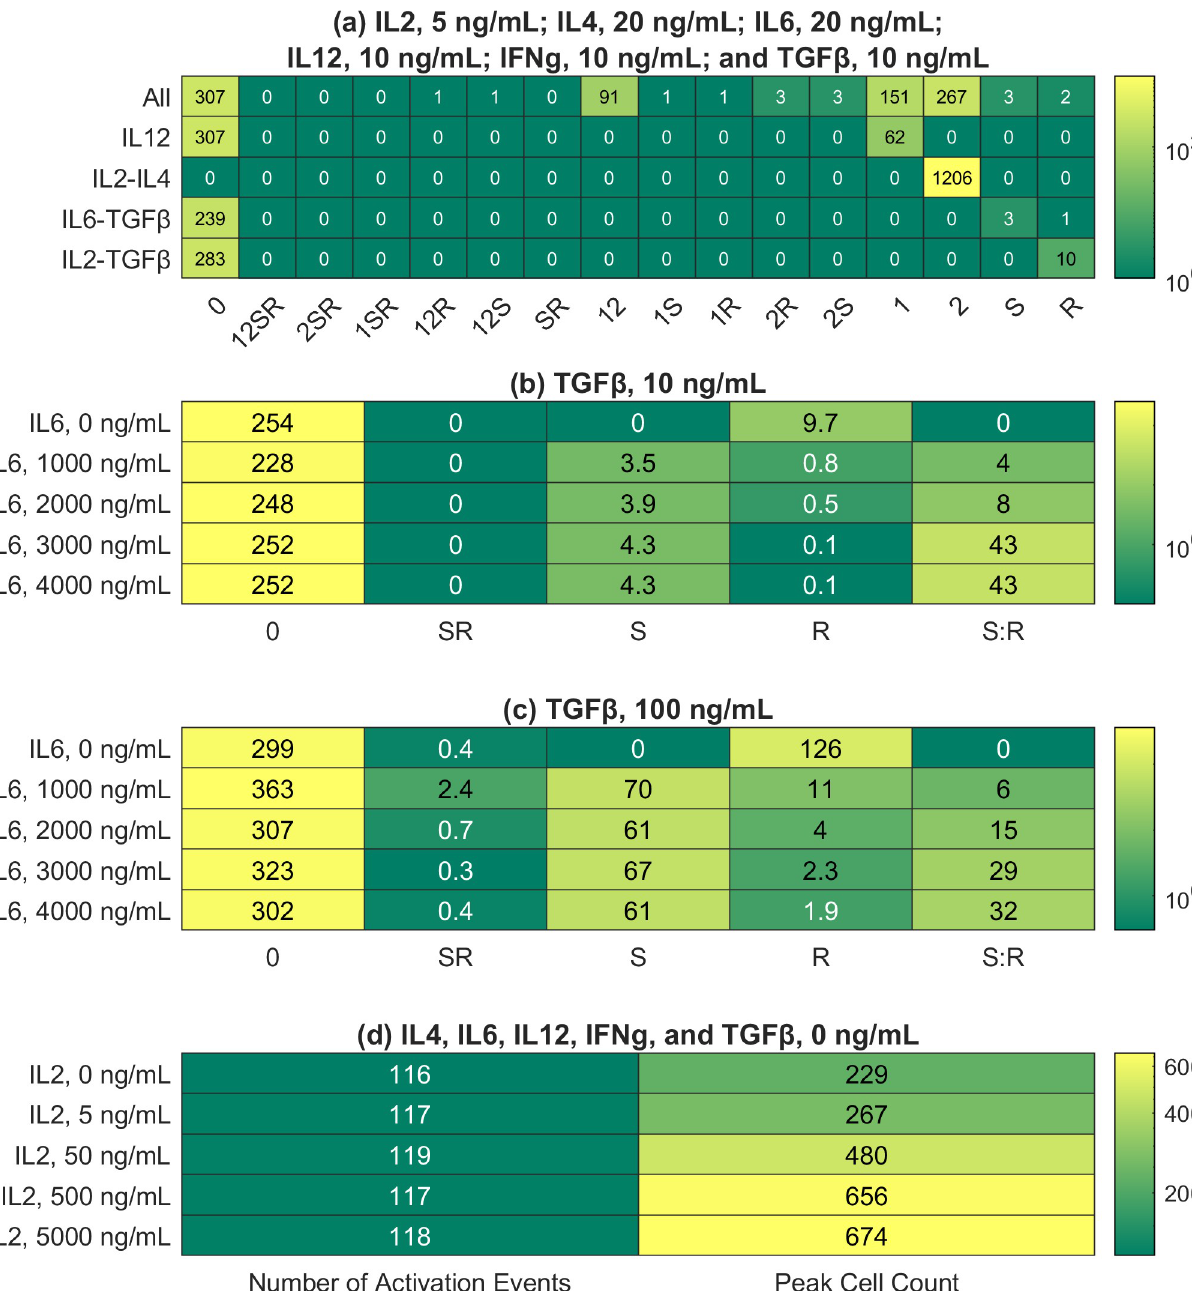
Fig 3. Peak CD4+ T cell responses in the presented simulations. Each row represents the peak CD4+ T cell response in a Monte Carlo simulation, where 50 realizations of the modeled system were generated and averaged, thus explaining the continuous values (see Methods and S1 Text for details). The peak is defined as the time point with the maximum number of effectors and reactivated memory cells. In the column labels, 0 represents Th0; 1, Th1; 2, Th2; S, Th17; and R, Treg. A combination of symbols represents a mixed phenotype; for example, 12 represents the Th1-Th2 hybrid phenotype. (a) Phenotypic distributions of CD4+ T cells in different cytokine media. The initial cytokine concentrations were set to match an experimental study [25]. The first row represents the case with IL2, IL4, IL6, IL12, IFN γ , and TGF β . (b) Phenotypic distributions of CD4+ T cells given different initial concentrations of IL6 (multiples of 20 ng/mL). In each simulation, the initial concentration of TGF β was set to 10 ng/mL, while the other cytokine concentrations were set to zero. S:R denotes the ratio of Th17 count to Treg count (c) Same as (b), except the initial concentration of TGF β was set to 100 ng/mL. (d) Total counts of naive cell activation and maximum cell counts given different initial concentrations of IL2 (multiples of 5 ng/mL). The initial concentrations of the remaining cytokines were set to zero.